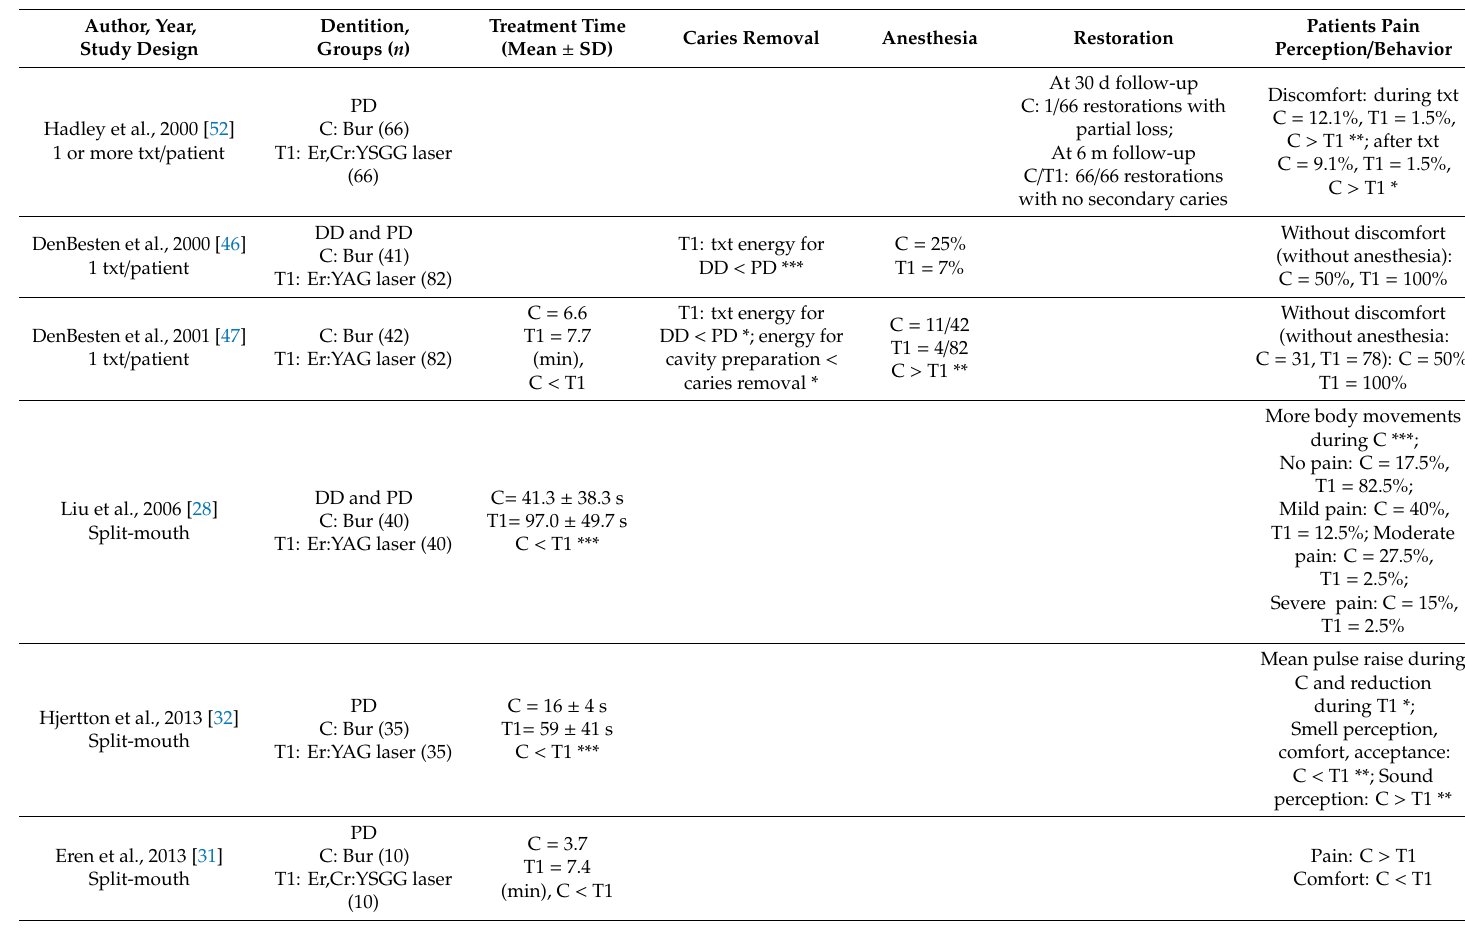
Table 5. Laser caries removal systems versus